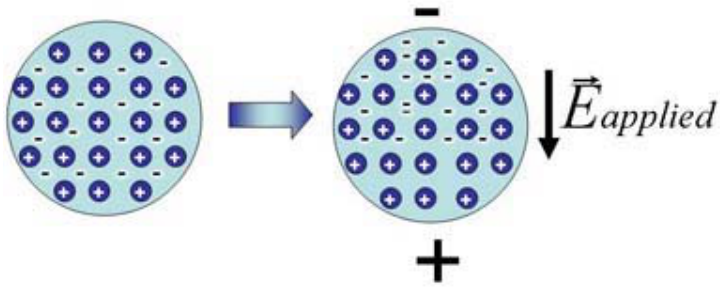
FIGURE 10. SPR of metallic NPs. When the light passes through the NP, the electric field makes the electrons oscillate inside the NP. The excess of charge creates an electric field opposite to that